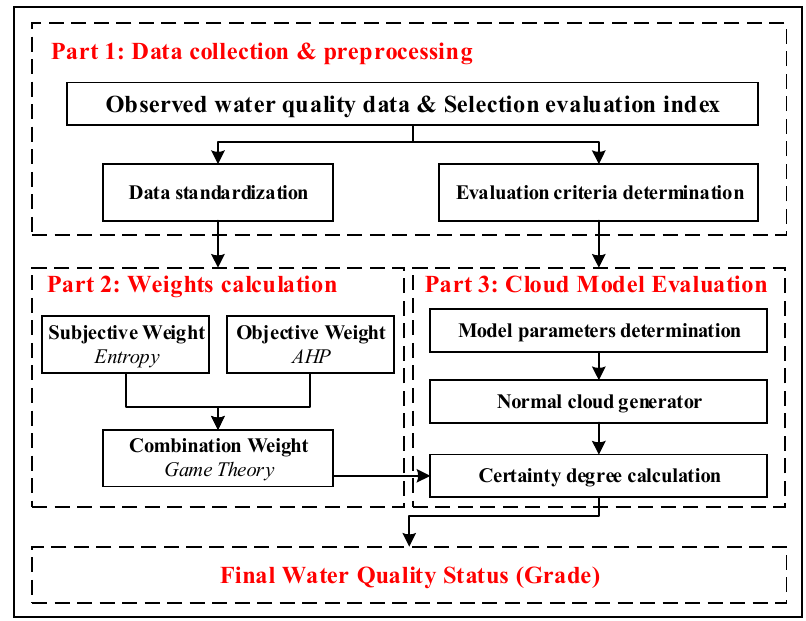
Figure 2. Framework of the cloud model-based water quality evaluation approach.